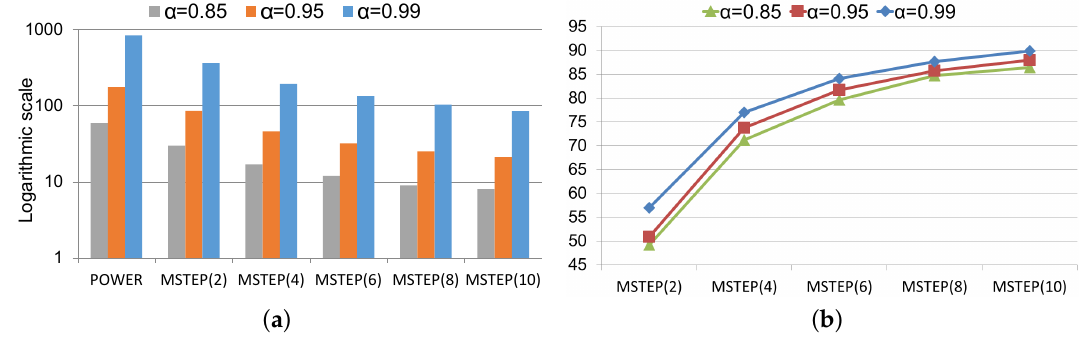
Figure 2. Comparison of convergence rates of the MSTEP methods with respect to the Power method, uk-2002, SM p = 4 ( 1 × 4 ) , (cid:101) = 10 − 6 . ( a ) Number of iterations. ( b ) Reduction of synchronization points (%).